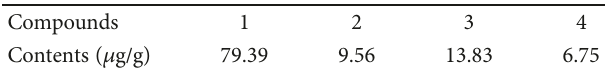
Table 4: Contents ( μ g/g) of 4 compounds in N. nucifera Table 3: Recoveries of 4 compounds in an N. nucifera embryo.